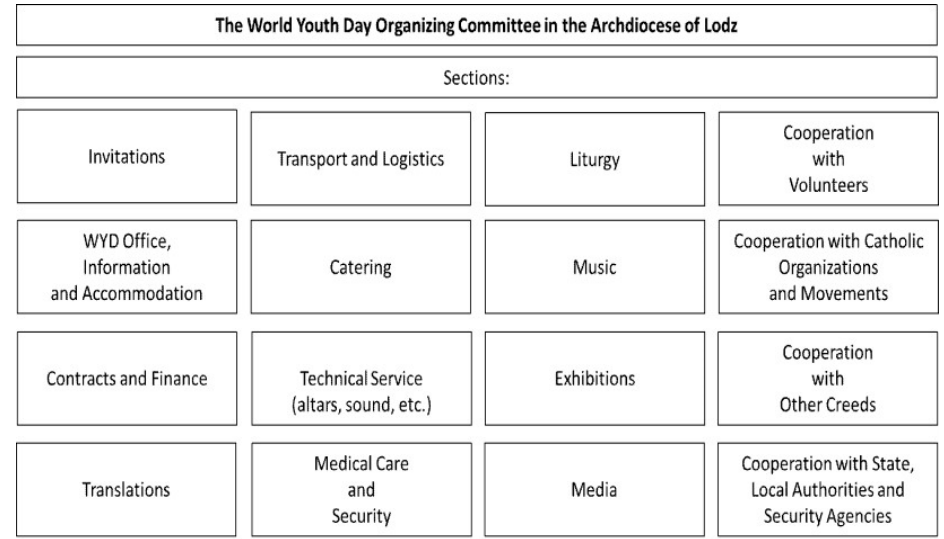
Figure 2. Structure of the WYD Organizing Committee of the Archdiocese of Lodz, 2016 (Source: authors).